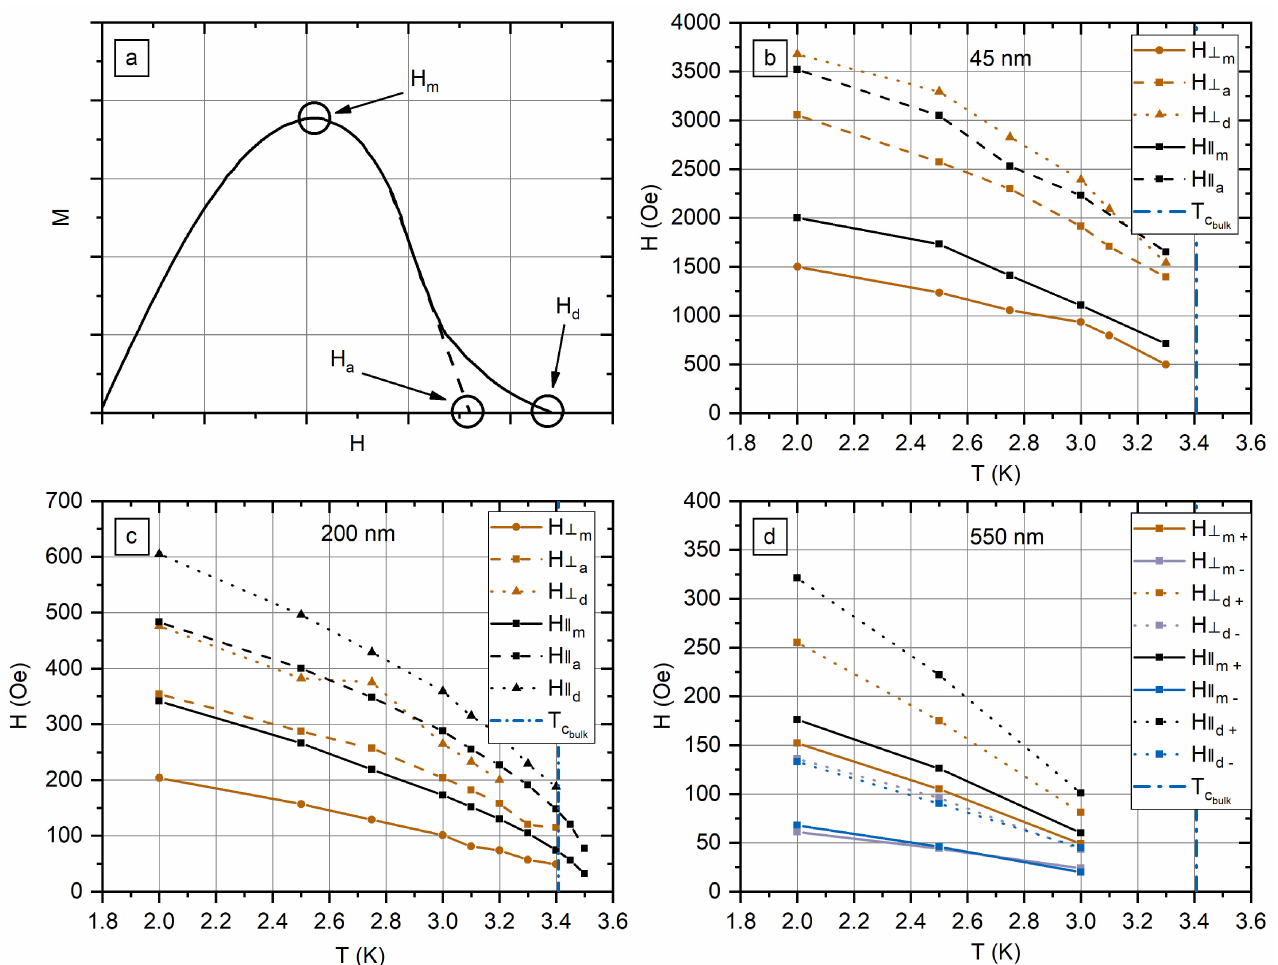
Figure 7. ( a ) Schematic illustration of the critical fields H m , H a , and H d on M ( H ) curve. Values of fields measured for the arrays of In nanowires with a diameter of 45 nm ( b ), 200 nm ( c ), and 550 nm ( d ). Values measured for increasing in modulus field H have index +, whereas values measured for decreasing in modulus field H have index −